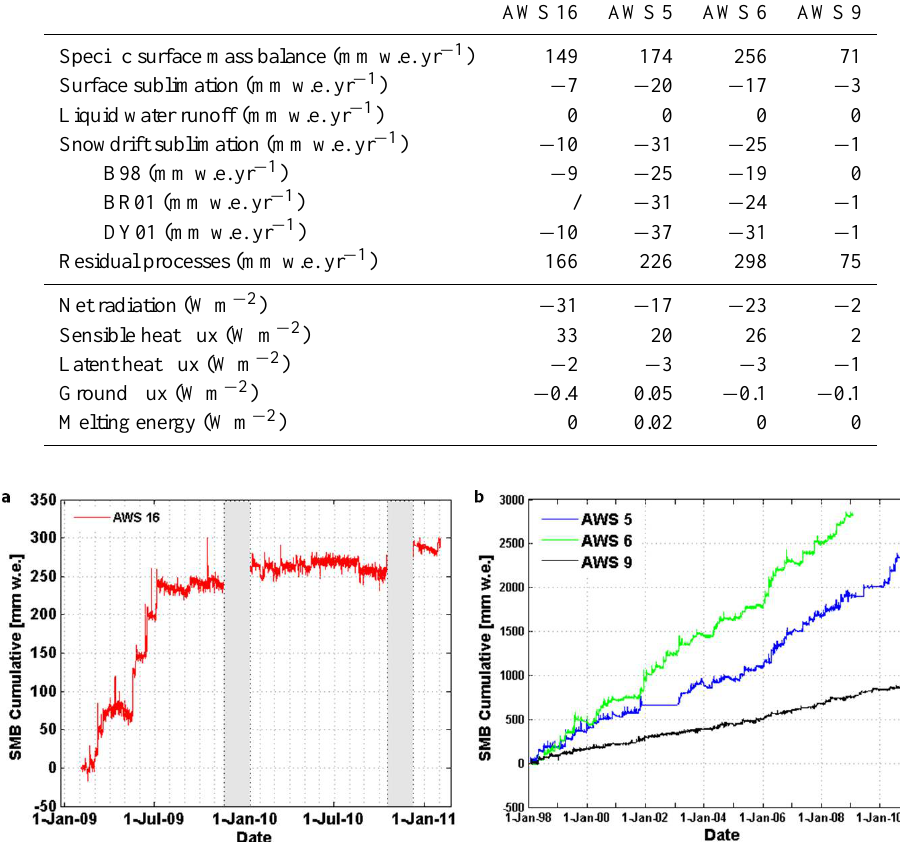
Fig. 4. Cumulative surface mass balance SMB (mm w.e.) for the respective measurement periods at (a) AWS 16 and (b) AWS 5, 6 and 9. Note that at AWS 16, accumulation during the December 2009 and November 2010 data gaps is captured by a jump in the snow height